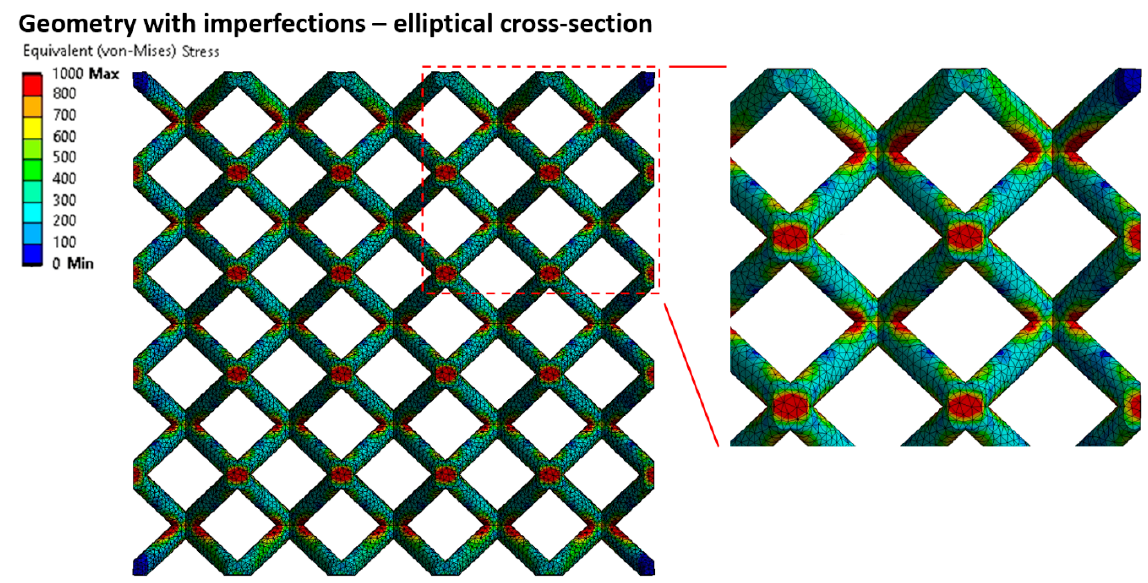
Figure 16. Equivalent (von Mises) stress distribution for a structure considering linear elastic material behavior—Elliptical cross-section (2.5% structure deflection).